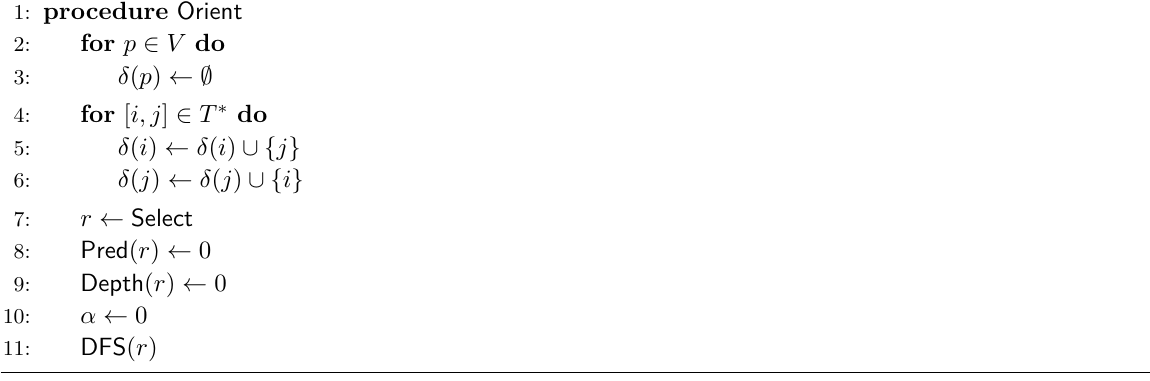
Algorithm 1 The procedure that orients the minimum spanning tree.